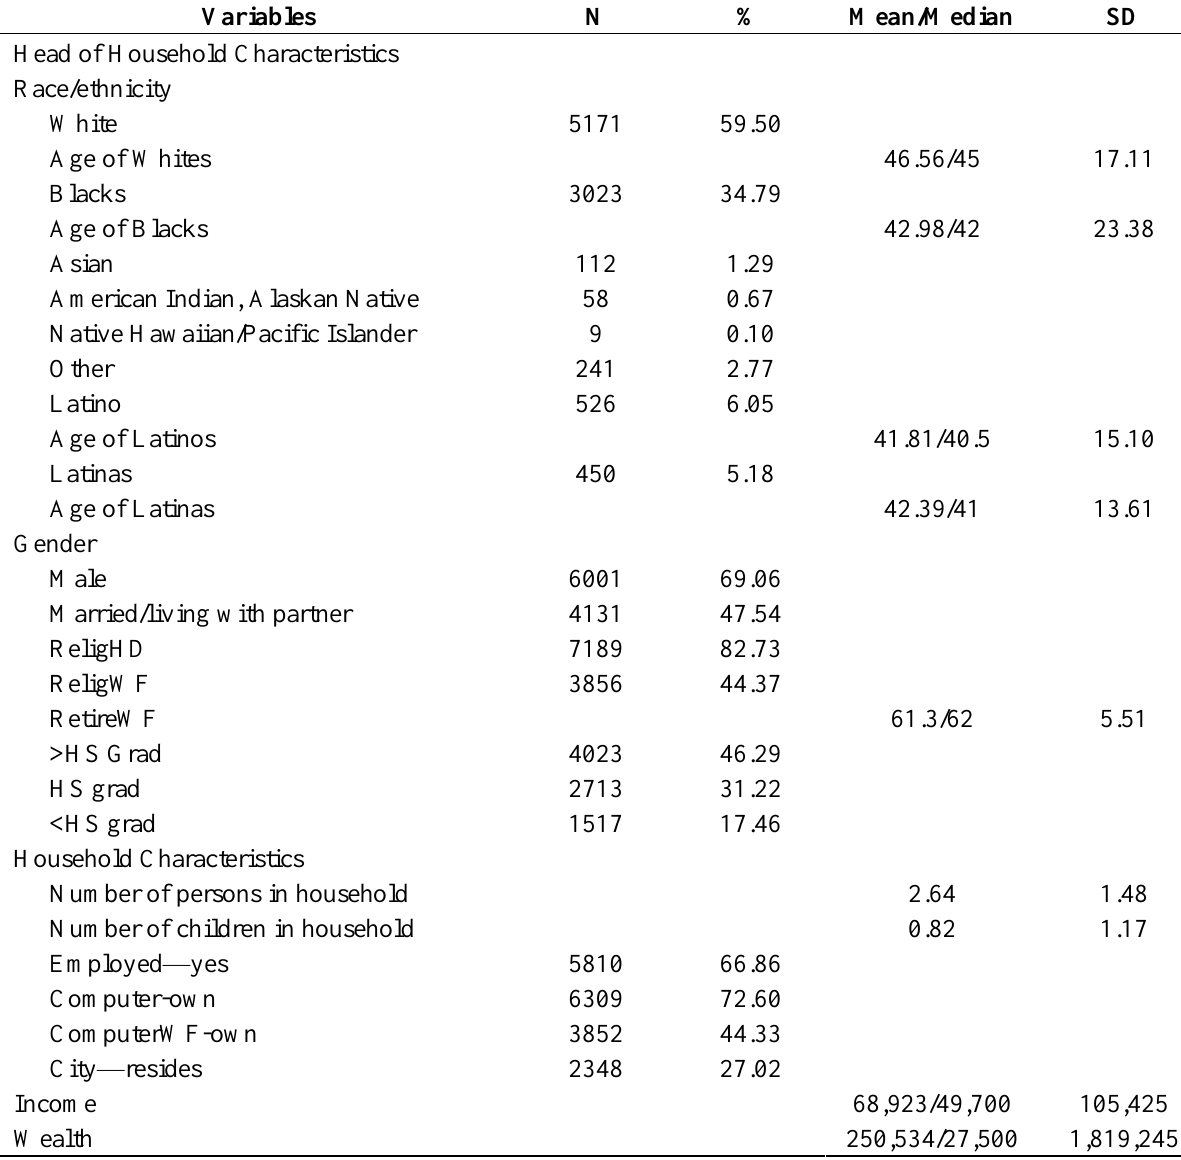
Table 3. Household characteristics of persons who gave to a charitable organization in 2008; N = 8,690